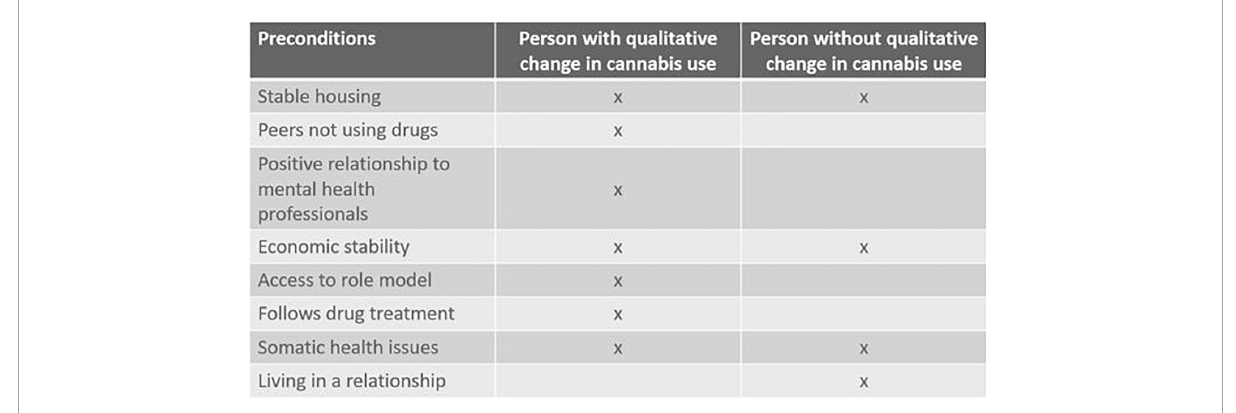
FIGURE5 The presence of factors possibly supporting transition to abstinence compared across two cases. The left column describes a 29-year-old female, the right column characterizes a 19-year-old male. Both were diagnosed with paranoid